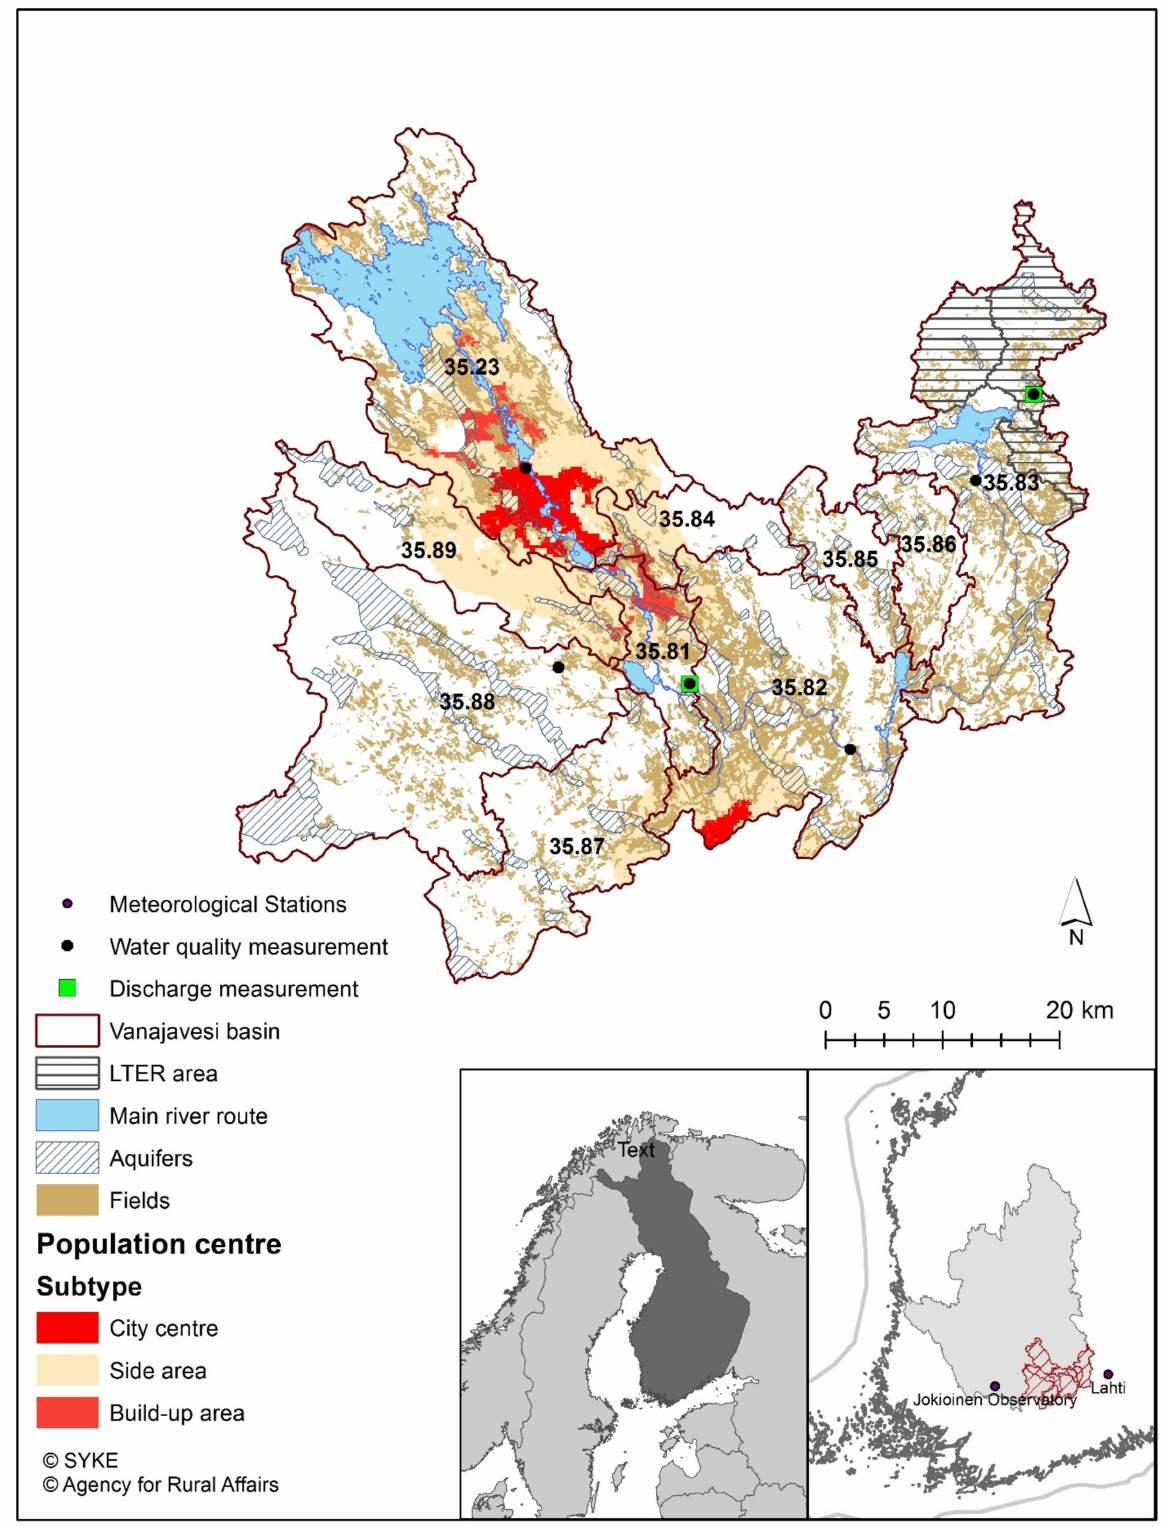
Figure 1. Location of the Vanajavesi basin and its